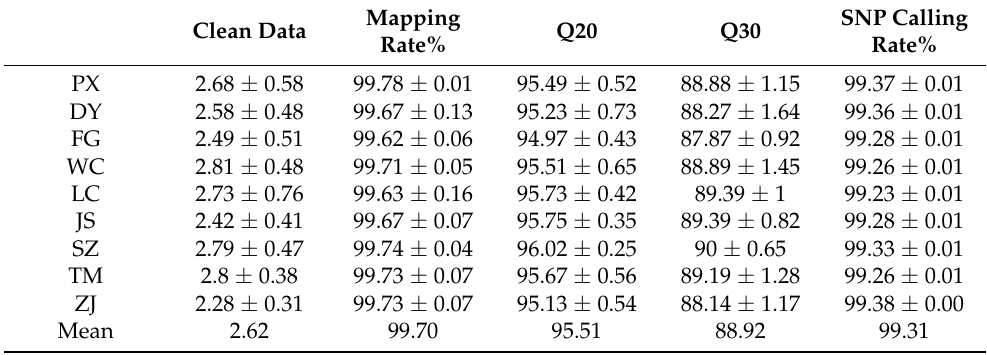
Table 4. The clean data, mapping rate, and Q20, Q30 and SNP calling rates of the nine populations. Clean Data